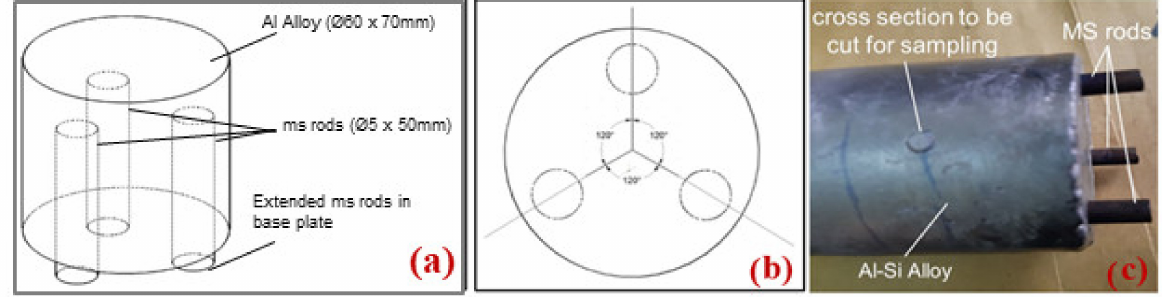
Figure 3. ( a , b ) Schematics demonstrating the length and location of the pins and ( c ) the actual cast component.